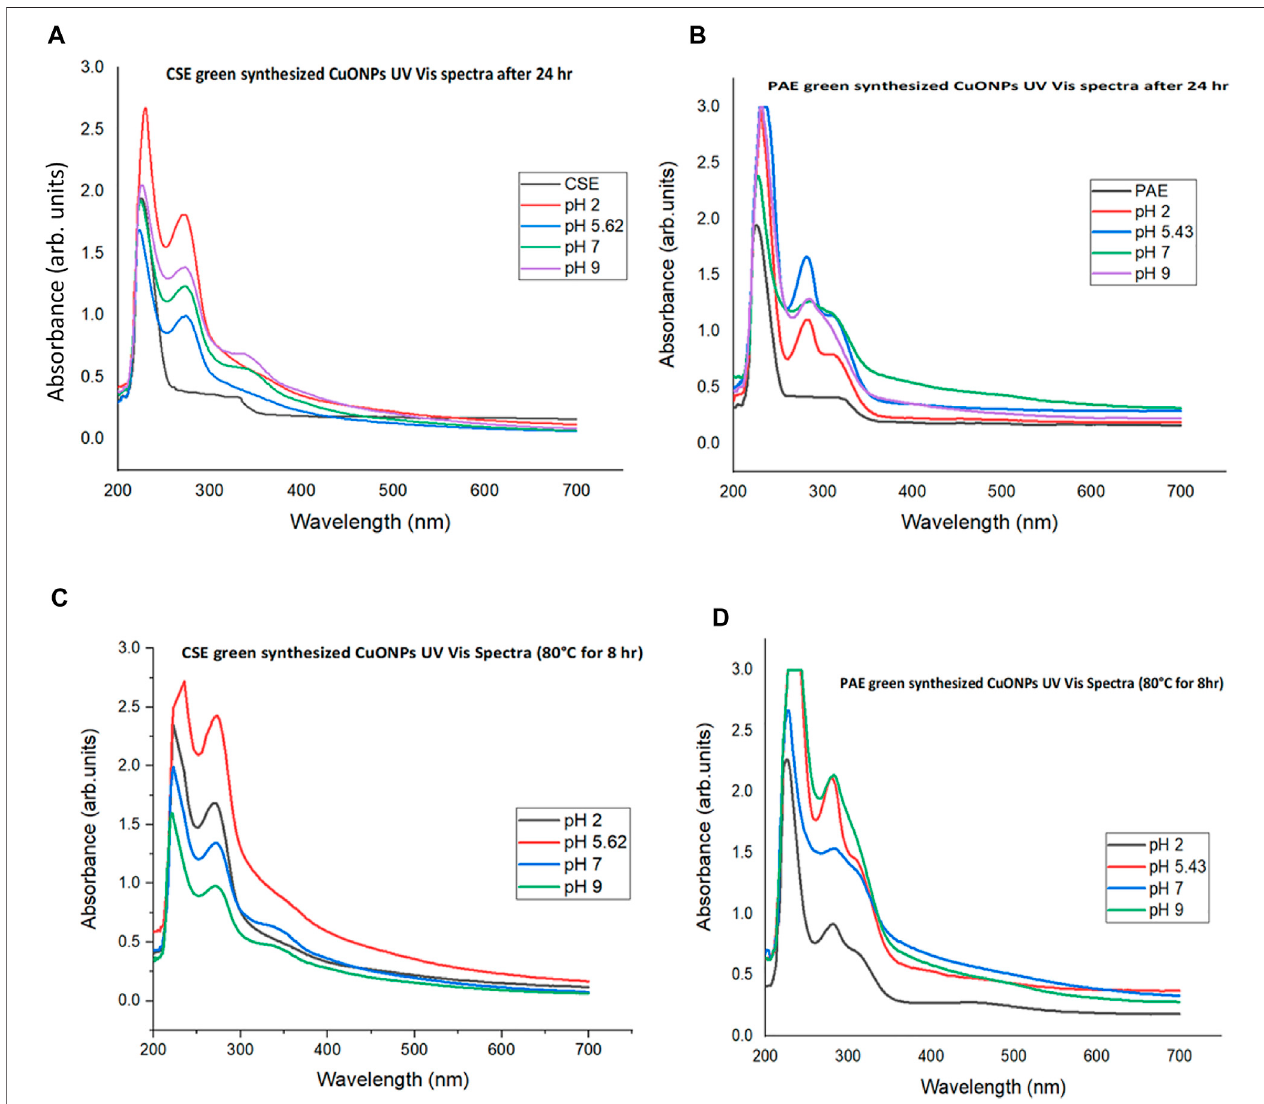
FIGURE 1 | UV Vis absorbance spectra for green synthesis of CuONPs at different pH Values. (A) : UV Vis spectra for CSE biosynthesized CuONPs at room temperature for 24 h, (B) : PAE biosynthesized CuONPs at room temperature for 24 h, (C) : CSE biosynthesized CuONPs at 80 ° C for 8 h, and (D) : PAE biosynthesized CuONPs at 80 ° C for 8